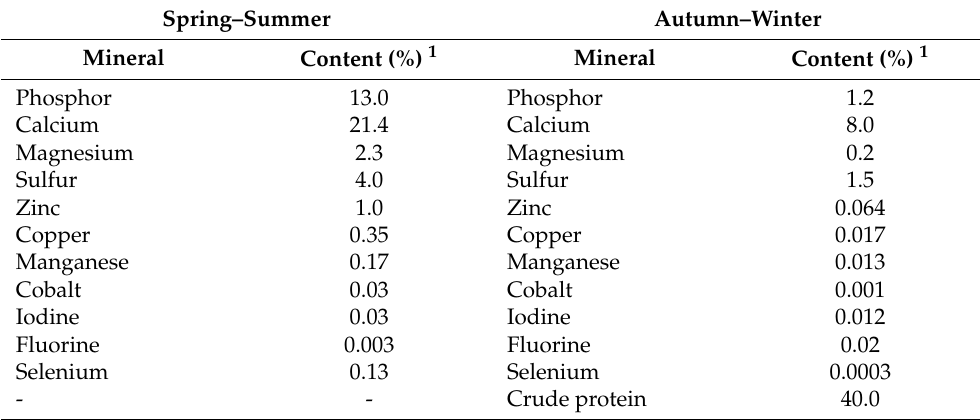
Table 2. Mineral supplement and proteinaceous mineral supplement.